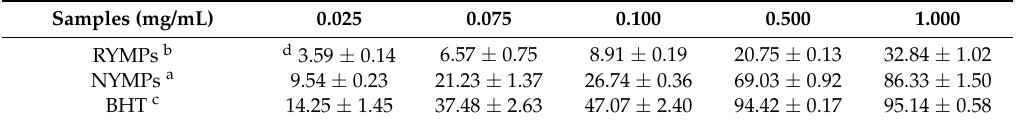
Table 1. DPPH radical scavenging activity of yellow Monascus